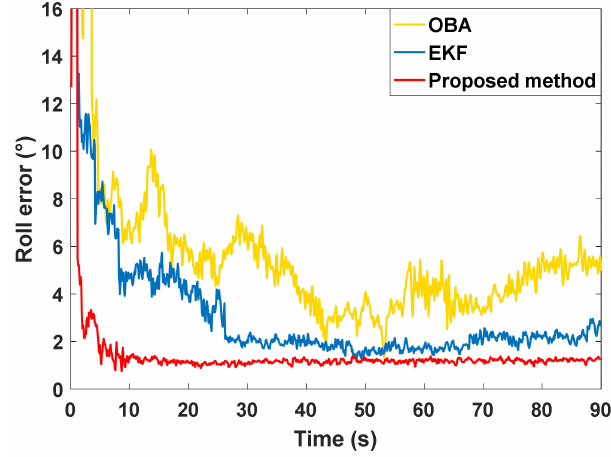
Figure 17. Roll angle alignment errors of three different IFA methods.